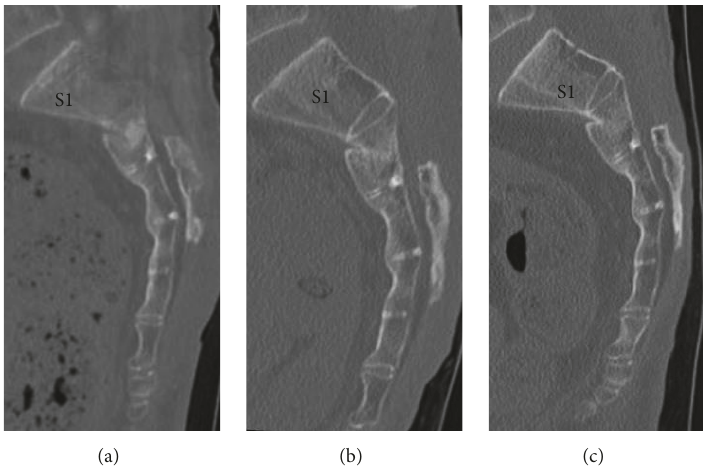
Figure 7: Follow-up sagittal reconstructed computed tomography (CT) images of the sacrum . (a) One-month sagittal reconstructed CT image. (b) Three-month sagittal reconstructed CT image. (c) One-year sagittal reconstructed CT image. The second sacral vertebral body was not displaced (a). The second sacral vertebral body contained a high-density area (b). The second sacral vertebral body had united without any displacement